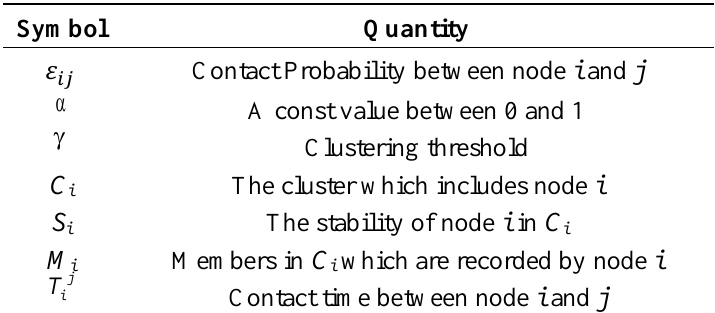
Table 1. List of